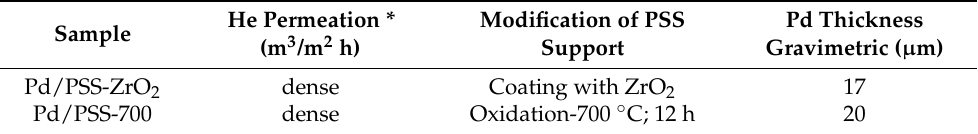
Table 4. Pd composite membranes